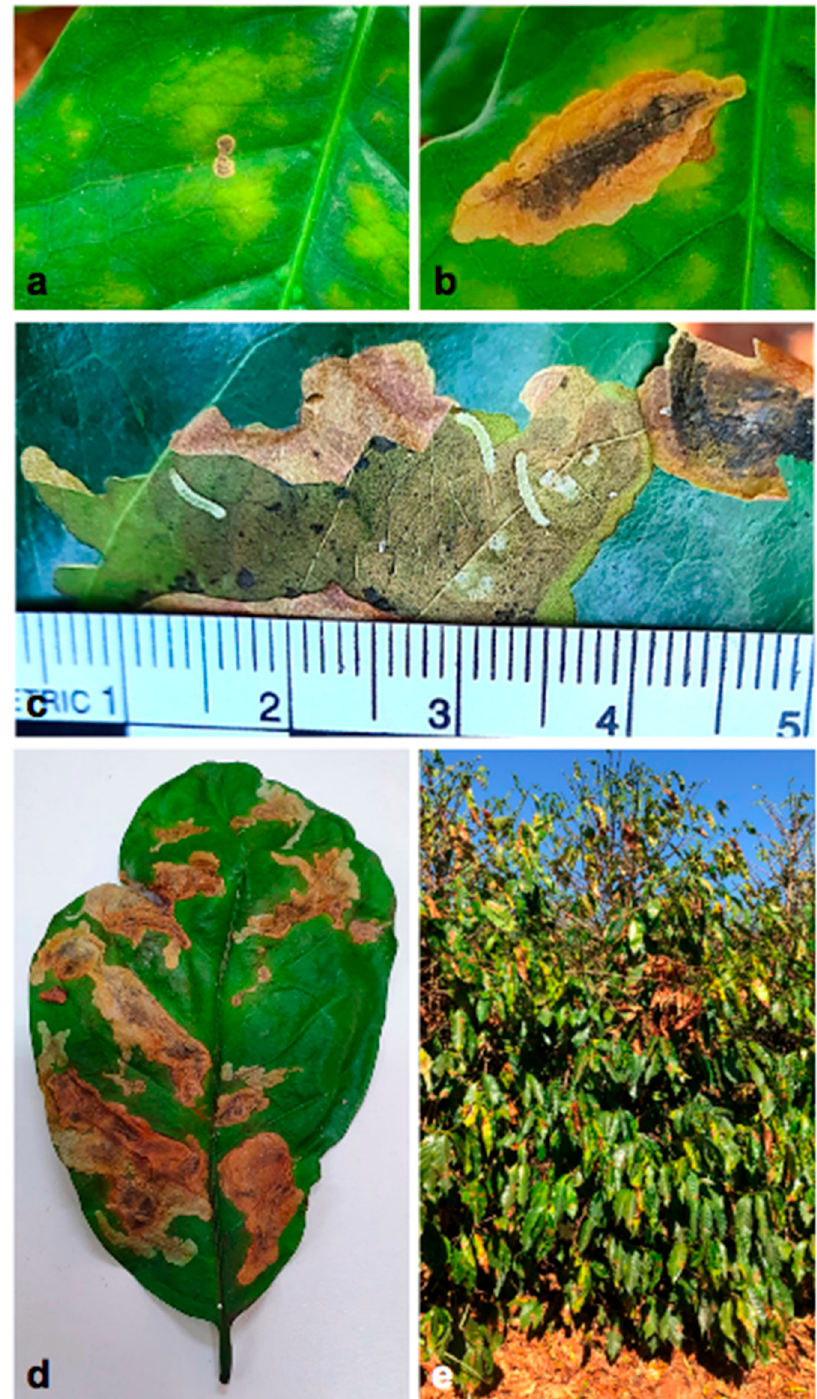
Figure 6. Damage to coffee leaf caused by the CLM larvae. ( a ) Initial mine formation; ( b ) mine de- veloped, with large necrotic area; ( c ) larvae inside the mine; ( d ) leaf with impaired photosynthetic surface; ( e ) coffee